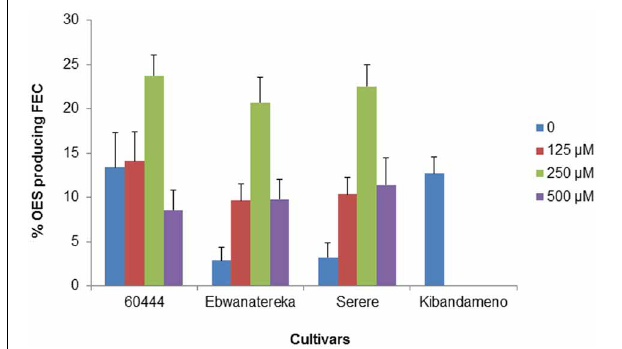
FIGURE 2 | Effect of L-tyrosine on the production of FEC from different cassava cultivars. FEC production frequencies were recorded by calculating the ratio of FEC clusters/OES cultured. Values are means ± SD of three independent experiments.